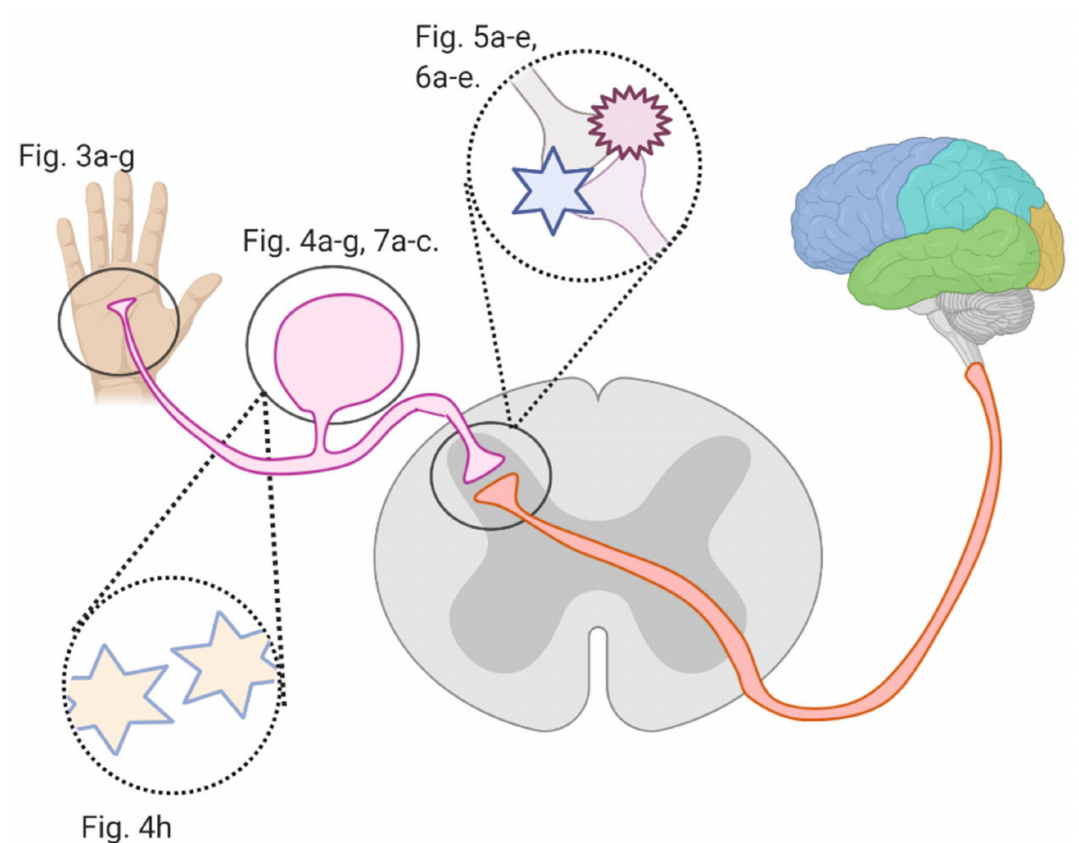
Figure 2. An overview of this article’s figures illustrating Regions where flavonoids interfere with signal transmission in CIPN; Figure 3a–g describe flavonoids’ and anticancer drugs’ actions at the periphery. Figure 4a–f describe flavonoids’ and anticancer drugs’ actions at the dorsal root ganglion. Figure 5a–d describe flavonoids’ and anticancer drugs’ actions at the spinal dorsal horn. Figure 6a–d describe flavonoids’ and anticancer drugs’ actions in astrocytes and glial cells. Figure 7a–b describe flavonoids’ and anticancer drugs’ roles in neuronal